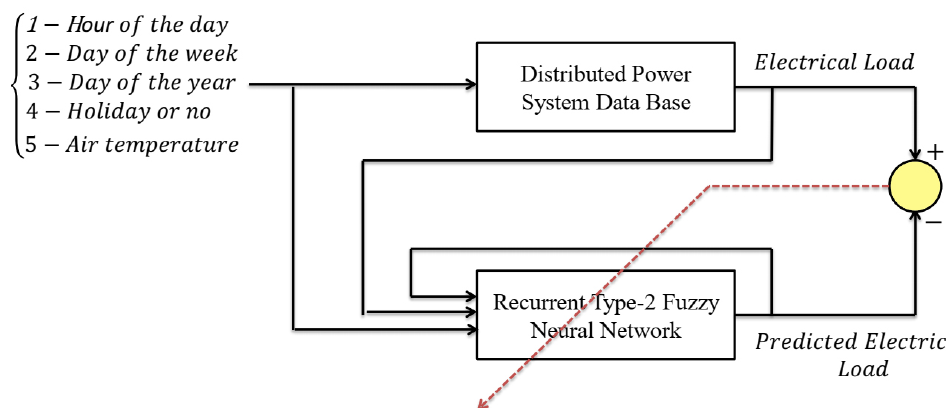
Figure 3. General diagram of the proposed load forecasting method.